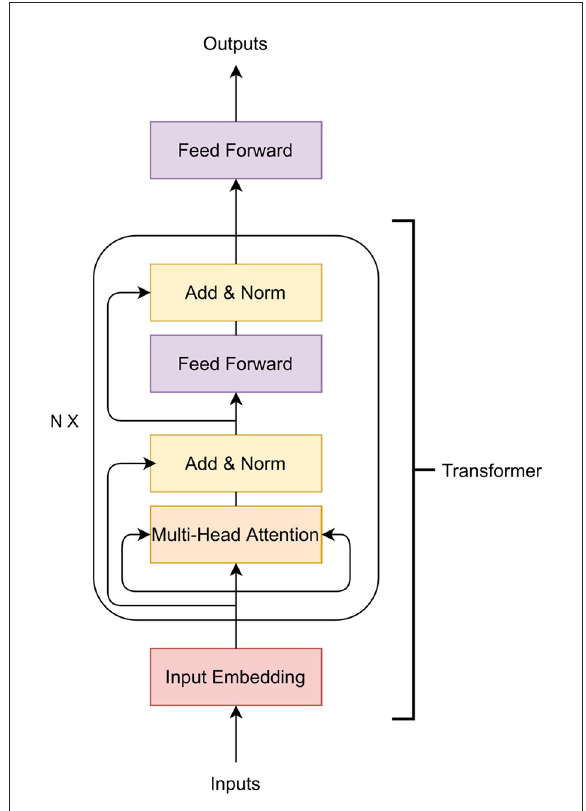
FIGURE4 A transformer encoder. Here N represents N transformers can be stacked